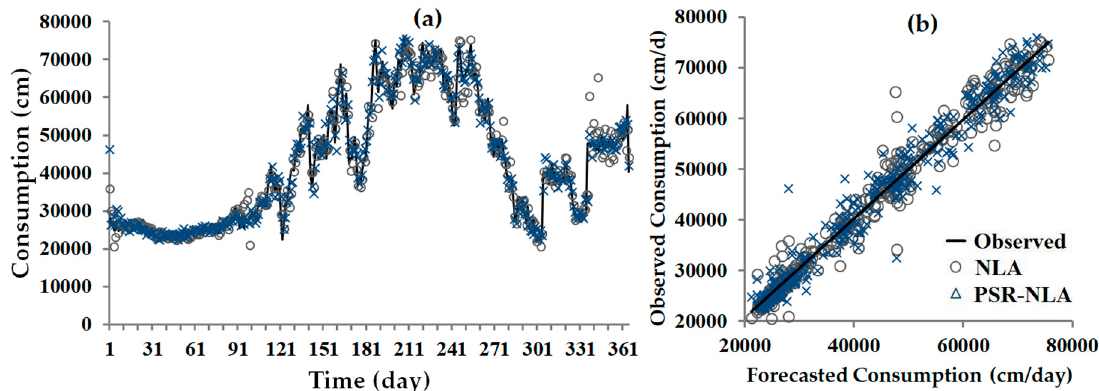
Figure 6. Forecasted values for water consumption by NLA (nonlinear local approximation) and PSR-NLA (phase space reconstructed-NLA) methods in comparison with observed values ( a ) consumption values time series ( b ) scatter pilot.